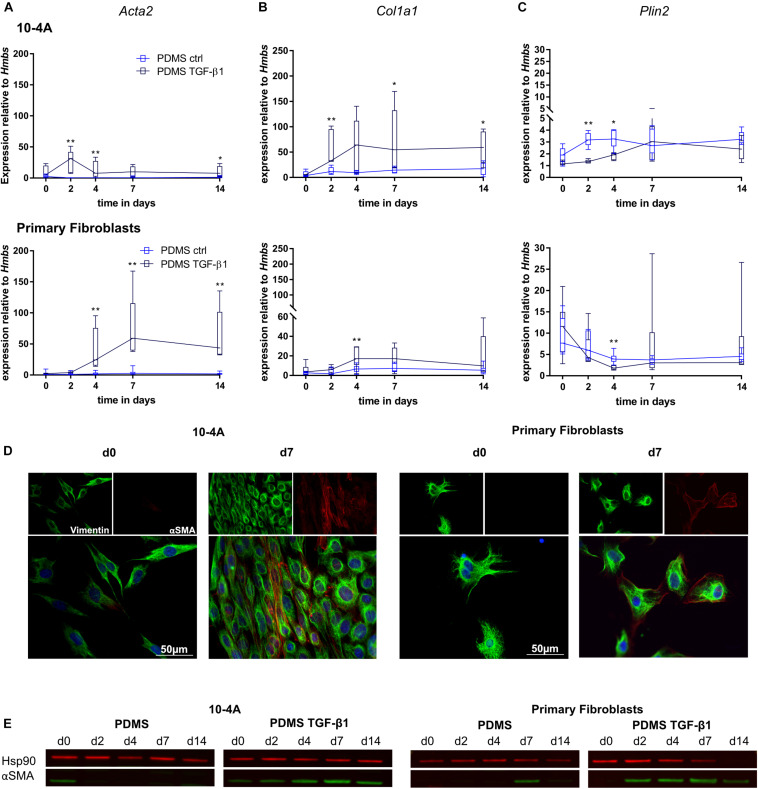
Chemical stimulation of 10-4A cells and primary fibroblasts with TGF-β1 on a physiological substrate. Semi-quantitative RT-PCR of Acta2
(A), Col1a1
(B), and Plin2
(C) expression in 10-4A cells (top graph) and primary fibroblasts (bottom graph) cultured in the presence or absence of 5 ng/ml TGF-β1 on a soft PDMS substrate, respectively. Data are expressed as fold expression of housekeeping gene Hmbs. Primary fibroblast data were obtained from 5 different animals, 10-4A data from five independent passages. The respective time points were tested with the non-parametric Mann–Whitney-U-Test. Statistical significance is indicated as follows: p-values < 0.05: *, p-values < 0.01: **. Box plots show data as median values, the boxes represent percentiles, the whiskers indicate the minimum/maximum. (D) Immunofluorescence staining of 10-4A cells (left) or primary fibroblasts seeded on PDMS with administration of 5 ng/ml TGF-β1 directly after adherence (d0) or 7 days post-seeding. Cells were stained for the mesenchymal marker vimentin (green) and the pro-fibrotic protein αSMA (red). Scale bar = 50 μm. (E) Western Blot for αSMA in 10-4A cells and primary fibroblasts cultured over 14 days on PDMS substrate in the presence or absence of TGF-β1, respectively. HSP90 was used as loading control.